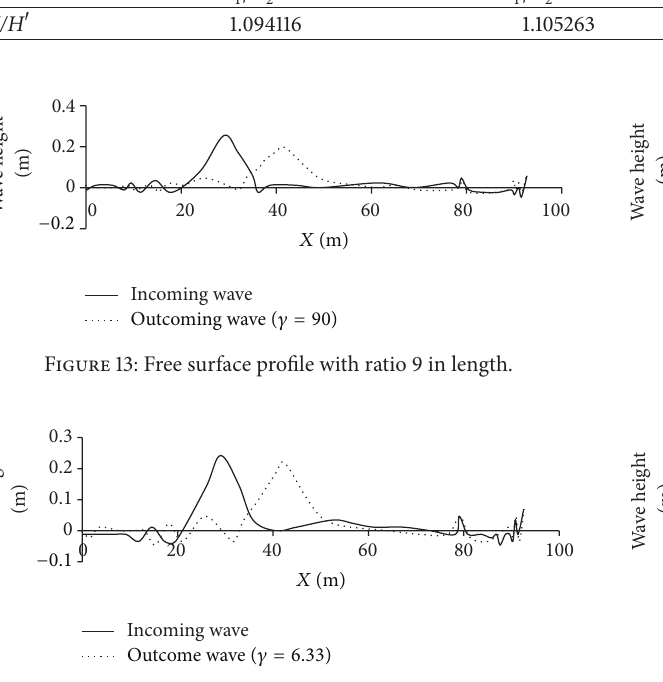
Figure 16: Free surface profile at length ratio 3.67.